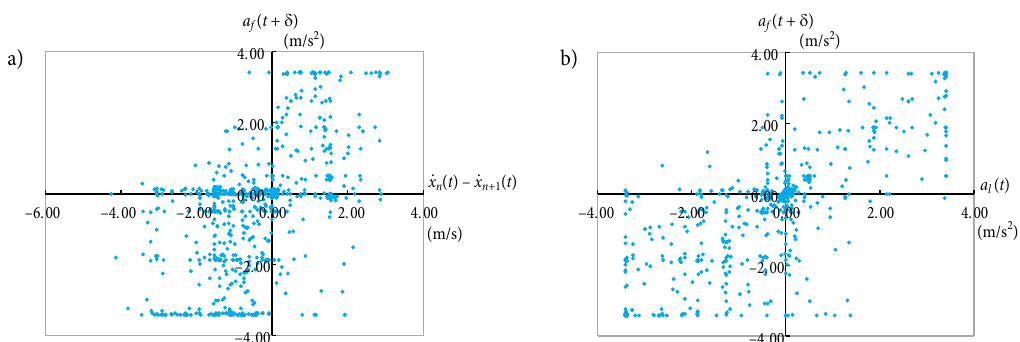
Fig. 2. The relationship of the follower’s acceleration ( a f ( t+ d )) to the speed difference from the leader and to the leader’s acceleration: a – the follower’s acceleration v.s. speed difference from the leader; b – the follower’s v.s. leader’s